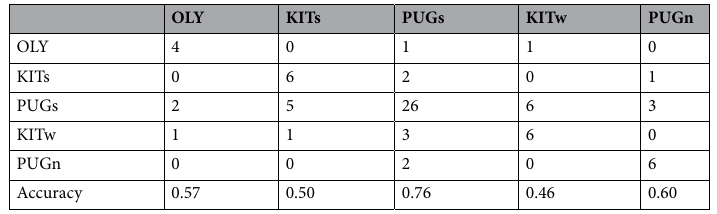
Table 6. Accuracy of correctly assigning a sample to its genetic group (assuming K -value = 5) using morphometric and meristic data in a linear discriminant analysis. The five groups tested from the Puget Sound region are: OLY Olympic Peninsula, KITs Kitsap Peninsula south, KITw Kitsap Peninsula west, PUGn Puget Sound north, and PUGs Puget Sound south.